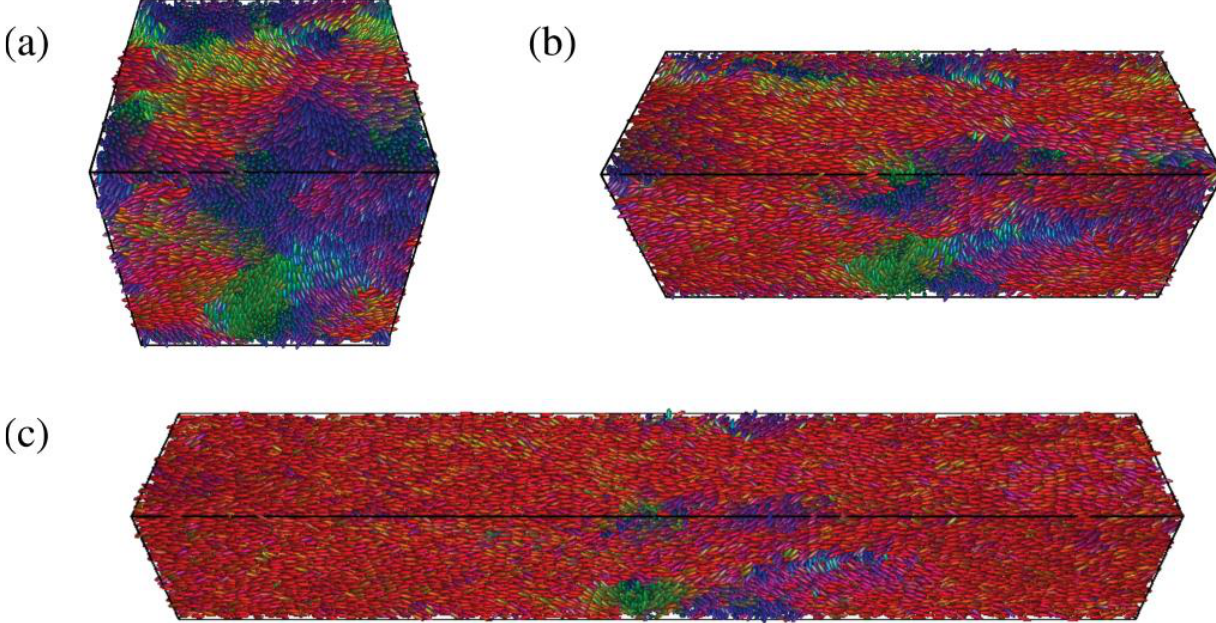
Figure 11. Results showing the configuration of LCEs, having rigid cross-linkers, at different stages, during a simulation where the strain-rate is kept constant. ( a ) Initial state, showing a clear polydomain structure. ( b ) Alignment begins after applying strain. ( c ) As the strain is further increased, only small misaligned clusters remain [8] (Reprinted with permission from [8]).